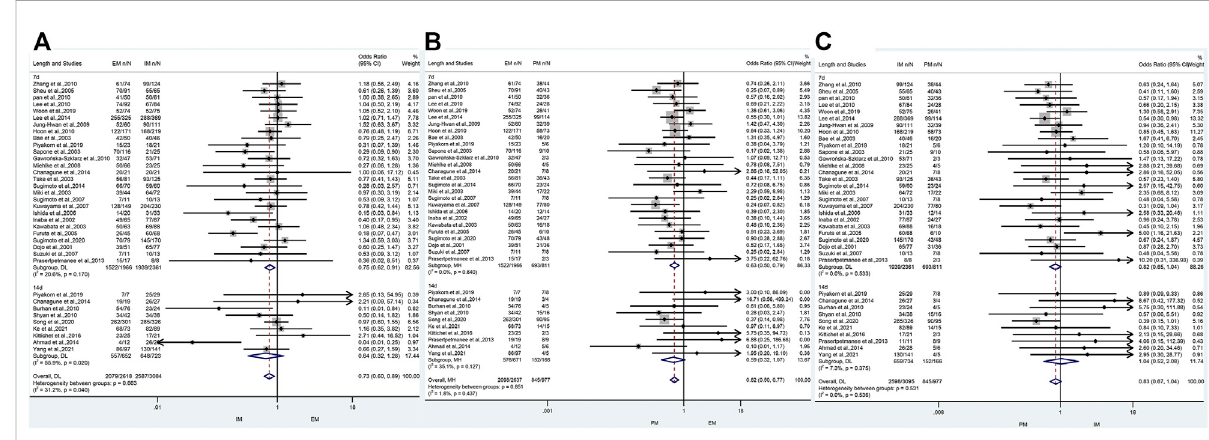
FIGURE 5 (A) Forest plot of EM vs. IM in relation to the H. pylori cure rate in the CYP2C19 genotype in different treatment duration ( p = 0.040). (B) Forest plotofEMvs.PMinrelationtothe H.pylori curerateintheCYP2C19genotypeindifferenttreatmentduration( p =0.437). (C) ForestplotofIMvs.PM in relation to the H. pylori cure rate in the CYP2C19 genotype in different treatment duration ( p = 0.536). p = 0.05, signi fi cant heterogeneity or statistically signi fi cant, when appropriate. p < 0.05, random-effects model; p > 0.05, random-effects model. Symbol: , single studies included in the meta-analysis; , sample size of single studies; , con fi dence interval (CI); , overall pool estimated; , tendency; , overall pool OR.